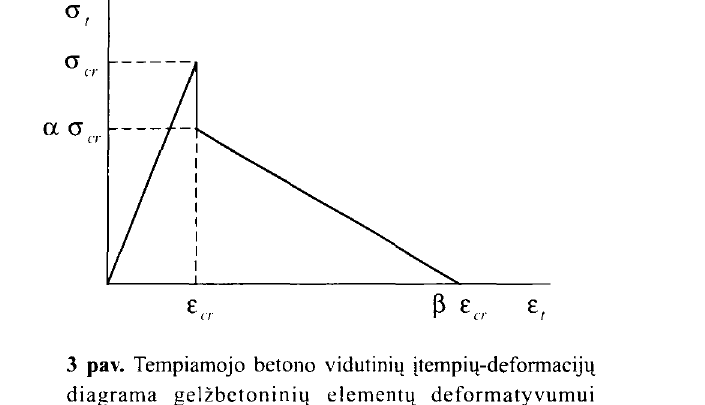
Fig 3. Average stress-strain relationship for concrete in tension for deformational analysis of reinforced concrete members